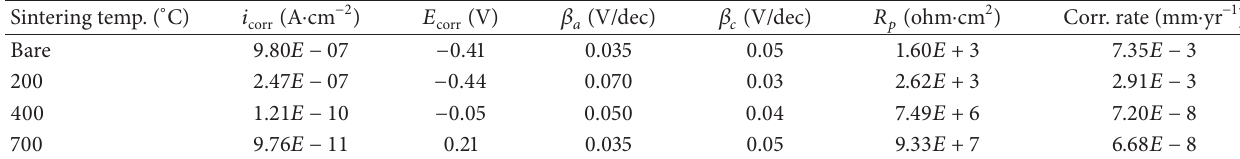
Table 2: The electrochemical parameters of coated and uncoated samples for different sintering temperature. Sintering temp. ( ∘ C)